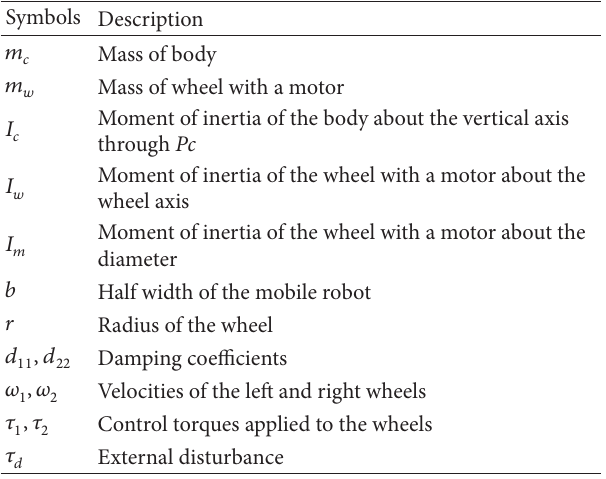
Table 1: Definition of parameters of mobile